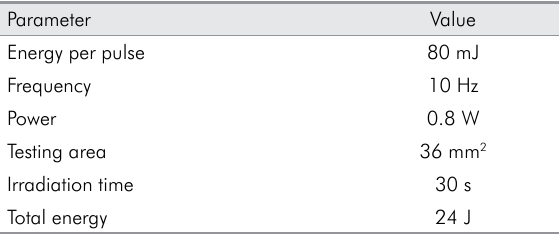
Table 2. Diode laser parameters used for irradiation of the testing areas.